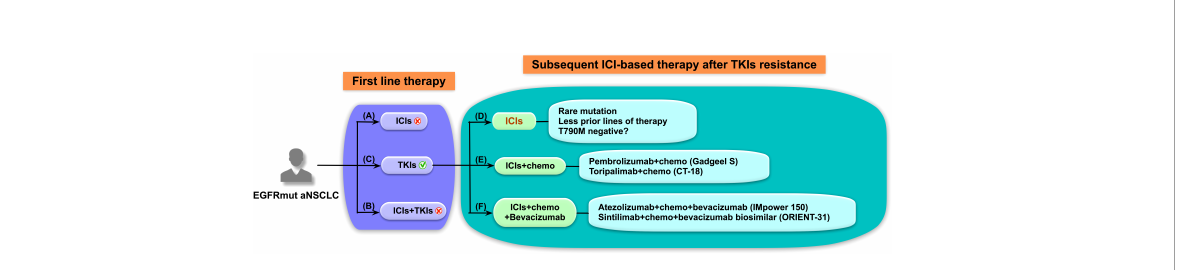
FIGURE 5 Schematic diagram of treatment strategies for advanced non-small cell lung cancer (NSCLC) patients with epidermal growth factor receptor (EGFR) mutations. Immune checkpoint inhibitor (ICI)-based treatment strategies for EGFR-mutated (EGFRmut) patients with advanced NSCLC should be elaborately designed. (A – C) In the fi rst-line setting, (A) ICIs was found to lack ef fi cacy and subsequent EGFR-tyrosine kinase inhibitors (TKIs) treatment possibly leads to severe immune-related adverse events, and (B) ICIs in combination with TKIs also resulted in high treatment- related toxicities and poor tolerance. (C) EGFR-TKIs are still preferred for the fi rst-line therapy of EGFRmut patients regardless of programmed cell death ligand 1 expression. (D – F) As for subsequent ICI-based therapy after TKIs resistance, (D) ICIs alone may have better ef fi cacy in EGFRmut patients with rare mutation or patients who had received fewer prior lines of therapy. ICI-based combined therapies, including (E) ICIs plus chemotherapy and (F) ICIs plus chemotherapy and anti-angiogenic therapy, have shown promising results in prospective clinical studies and represent the future treatment strategies and direction for these